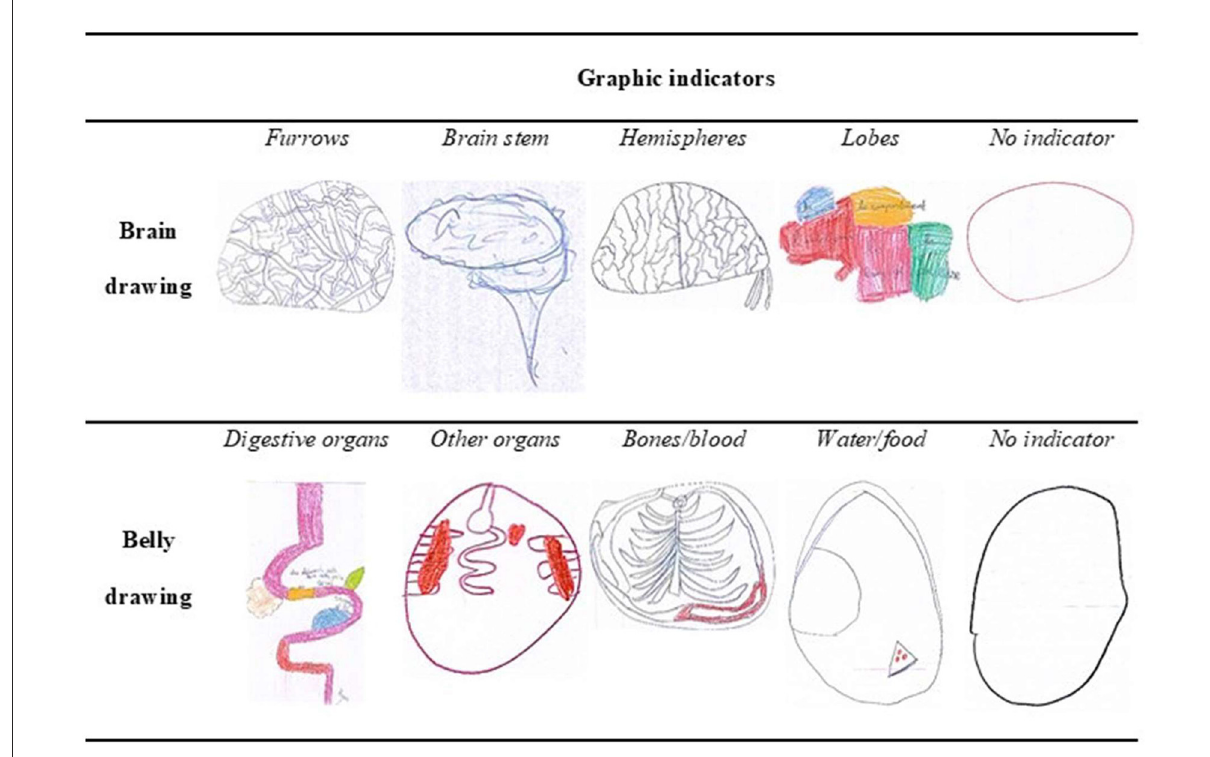
FIGURE1 Examples of drawings for each type of graphic indicator relative to the brain and to the belly drawings.